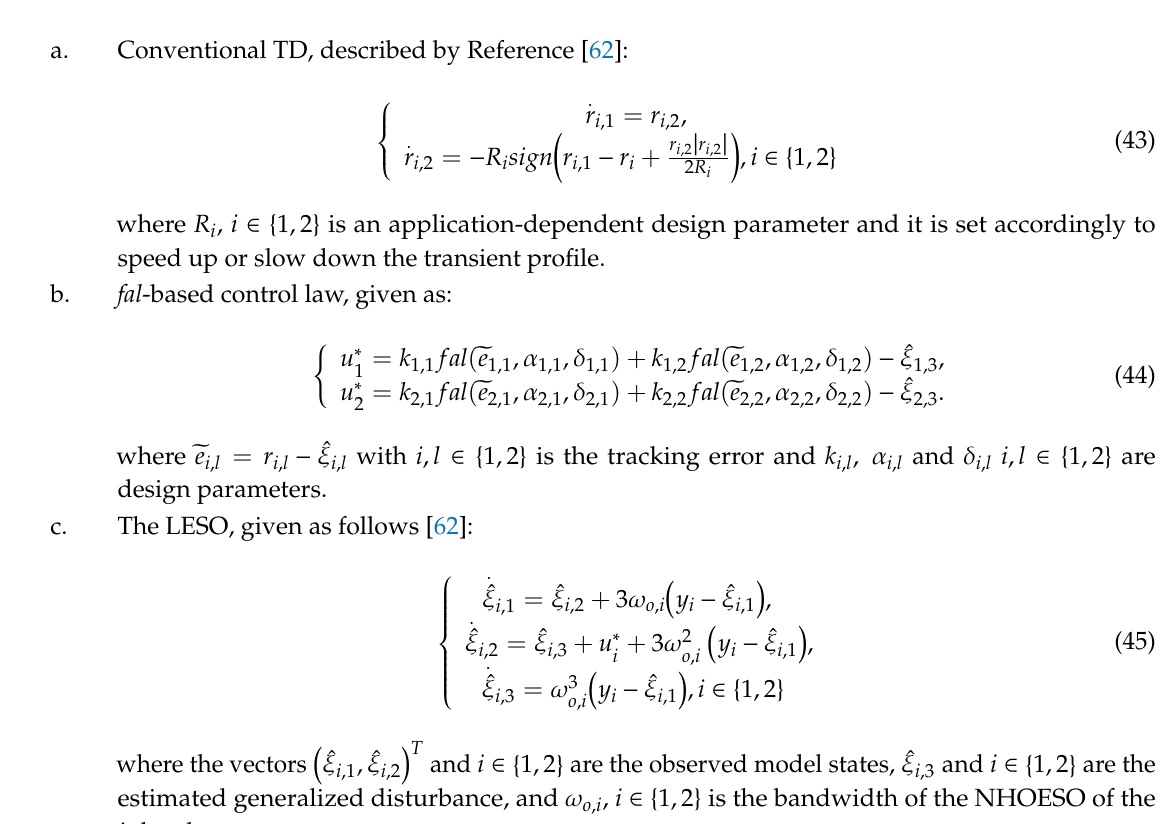
Figure 5. The proposed decentralized ADRC control scheme, where each ADRC block involves a SISO connection of TD, NLSEF, and ESO, as in Figure 1.